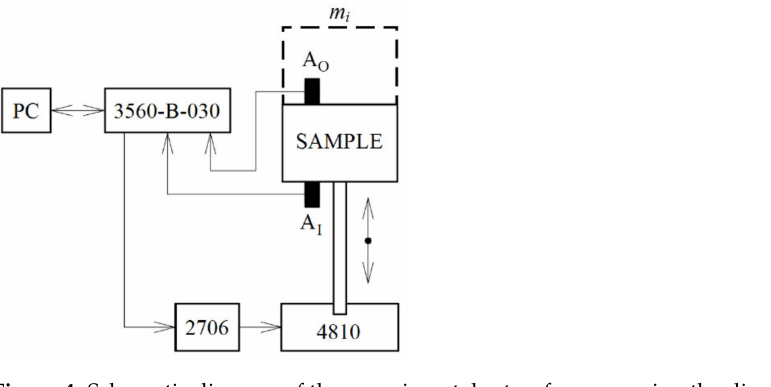
Figure 4. Schematic diagram of the experimental setup for measuring the displacement transmissi- bility of a linear single-degree-of-freedom system.